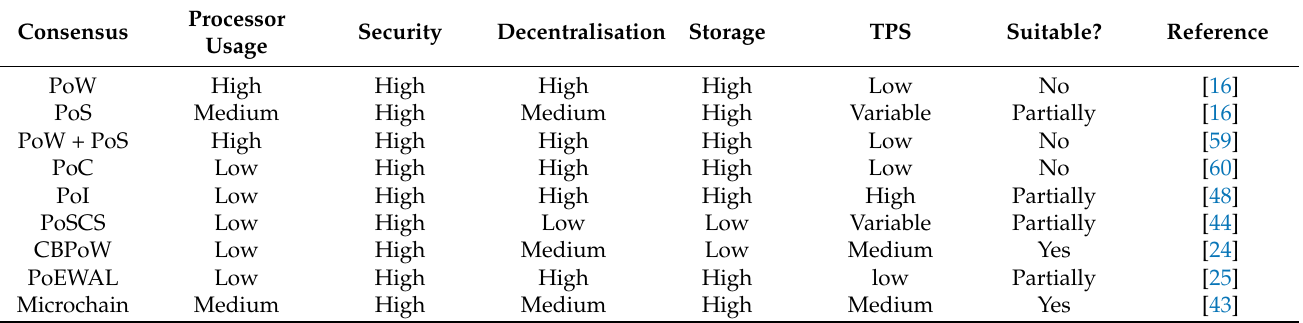
Table 3. Consensus mechanism suitability for IoT devices, measured against our criteria defined in Section